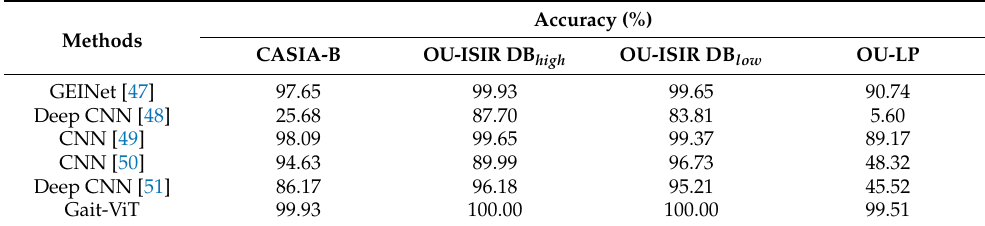
Table 7. Comparison results on different